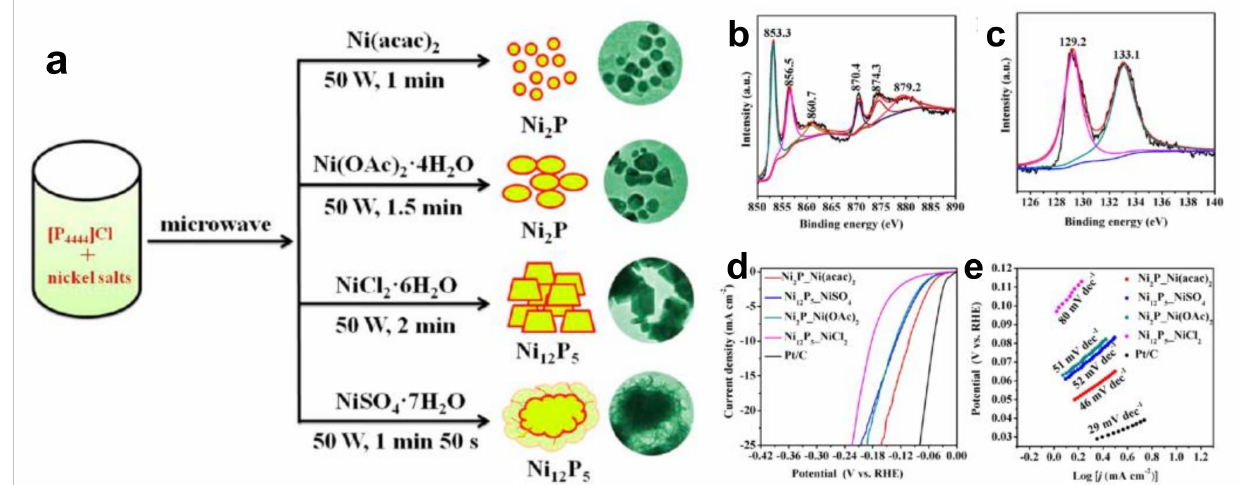
Figure 6. Typical schematic illustration for synthesizing various nickel phosphides controlled by the counter anions of nickel salts ( a ), XPS spectra of the Ni 2p ( b ) and P 2p ( c ) regions for Ni 2 P_Ni(acac) 2 nanocrystals, polarization curves of the as-synthesized Ni x P y catalysts ( d ) and Tafel plots of catalysts ( e ) for HER. Reprinted with permission from ref. [24], copyright 2018